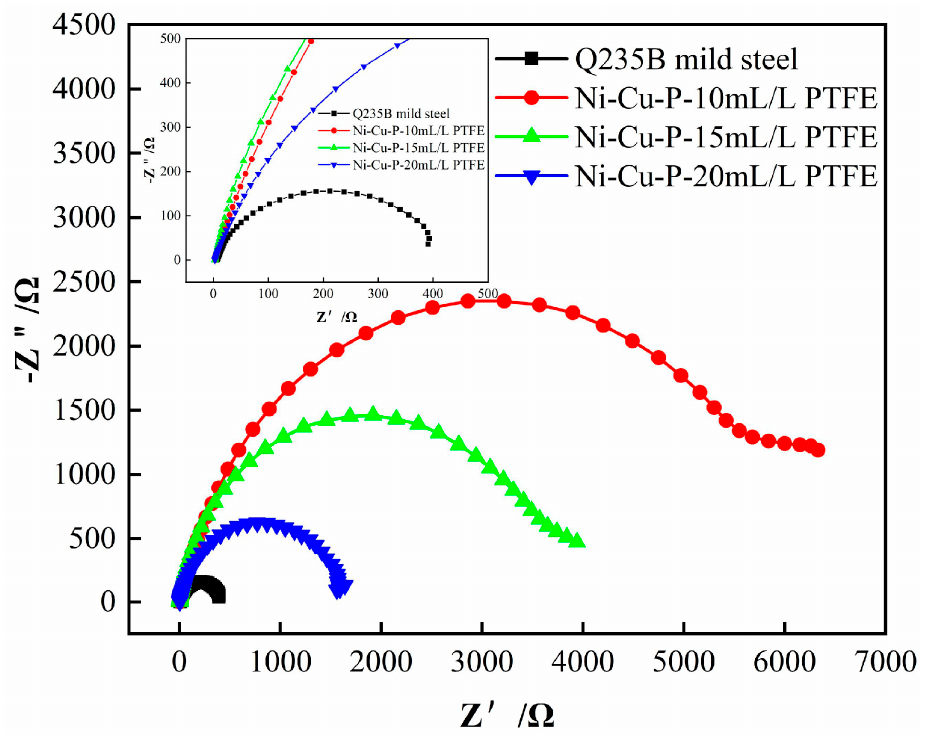
Figure 9. Impedance diagram of Ni-Cu-P-PTFE composite coating for Q235B mild steel and different PTFE concentrations.